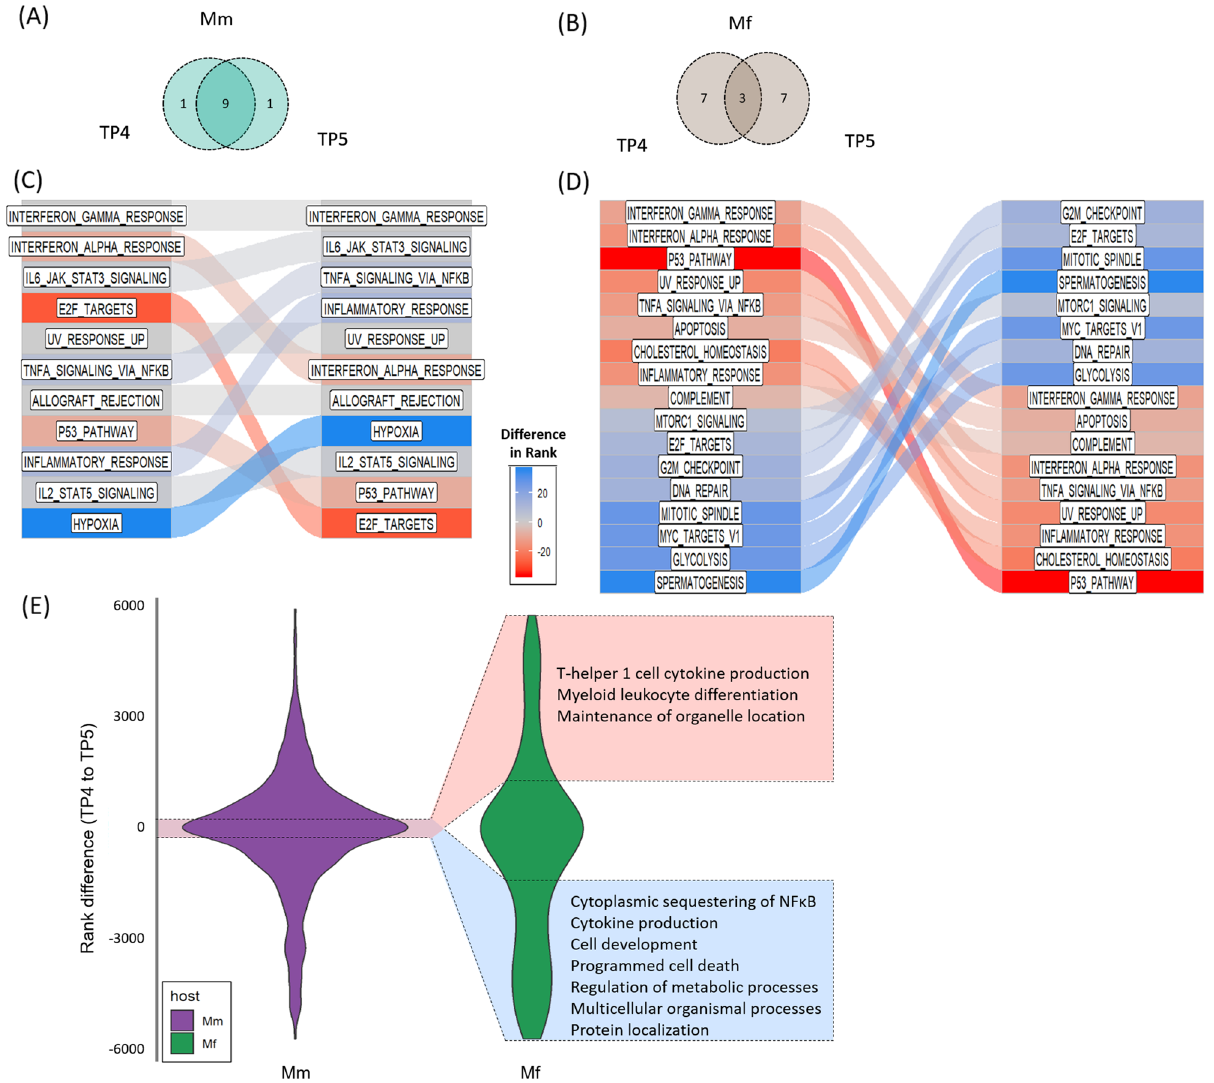
Figure 4. Changes in enriched pathways from TP4 to TP5 in Mm and Mf. ( A , B ): Venn diagrams of top 10 enriched pathways at TP 4 and TP5 for Mm and Mf, respectively. In Mm, 9 out of the top 10 are common between the two TPs. In Mf, only 3 out of the top 10 are common. ( C , D ): Ranking, from top to bottom, of most enriched pathways in Mm and Mf, respectively, at TP4 and TP5 (left to right). For each host, the changes in ranks of the top pathways between TP4 to TP5 are shown. Each list contains the union of the most significantly changed gene sets, ordered by their enrichment score. The top ranked gene set is the most enriched. Connectors show changes in rank for each gene set between the two TPs. Red shading indicates increases in rank and hence decreased enrichment from left (TP4) to right (TP5). Blue shading indicates decreases in rank and thus increased enrichment from TP4 to TP5. Color shades are proportional to relative changes in rank considering all gene sets (not just the ones shown). For instance, the darker shade of red for p53 pathway in panel D represents a sharp decrease in rank. ( E ): Violin plots of rank differences, representing the importance of gene sets, between TP4 and TP5 in the two host species. The vertical axis represents the distribution of rank differences between TP4 and TP5 for GO gene sets in Mm and Mf. Each data point in the two distributions represents one GO gene set (see Methods for details). The transition from TP4 to TP5 in Mm is characterized by a distribution (shown in purple) with 0 mean and a broad, rather than narrow distribution, which corresponds to relatively small changes in the importance of most gene sets. By contrast, the distribution of ranks in Mf (shown in green) has a much narrower distribution at the mean, with heavy tails, indicating many more changes in rank, overall. Both red and blue domains represent pathways that are important in Mm during both TP4 and TP5. In Mf, the red domain represents pathways that were not important at TP4 (higher ranked/lower enrichment) but become more important at TP5 (lower ranked/higher enrichment), while the blue domain represents pathways that were important at TP4 but become less important at TP5. The striking difference between these distributions demonstrates that Mf alters and refocuses its gene expression profile between TP4 and TP5 towards cell proliferation, etc. In contrast, Mm’s gene expression remains almost unchanged, still emphasizing the immune